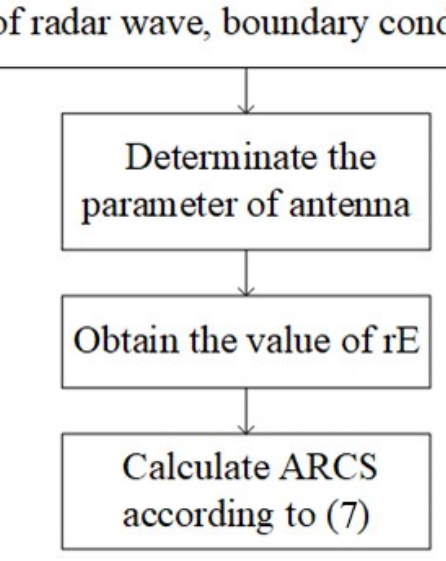
Figure 2. The entire flow diagram of ARCS simulation procedures. Simulations were designed to validate the active echo cancellation using the ARCS concept. We built a model of an aircraft with a dual antenna structure and added plane wave excitation to the aircraft in the head-on direction. The active echo cancellation is achieved by using the antenna to transmit an electromagnetic wave signal and adjusting the amplitude and phase of the signal emitted by the antenna. We then calculate its monostatic ARCS by HFSS simulation. More details are presented in Section